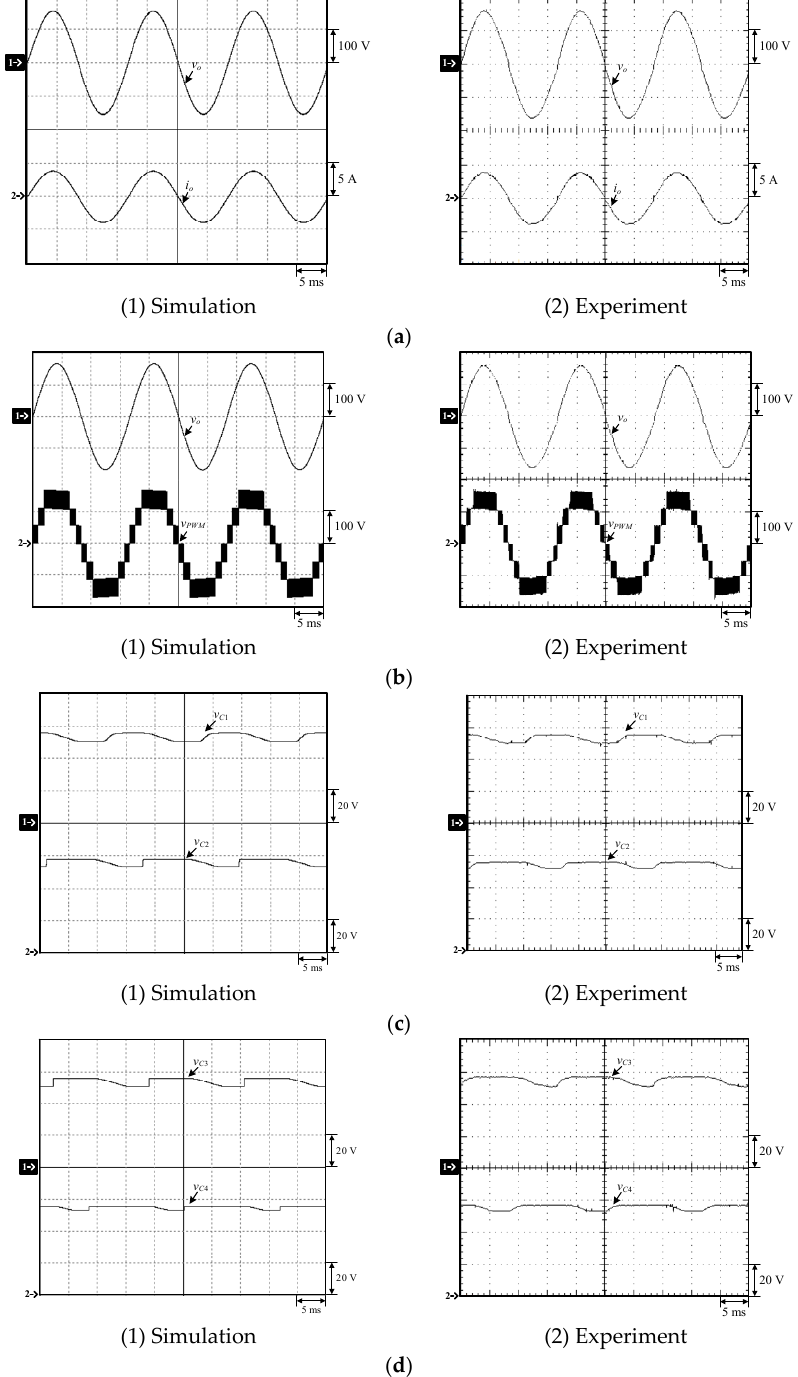
Figure 16. Simulated and experimental waveforms of the proposed DC-AC converter: ( a ) v o and i o ; ( b ) v o and v PWM ; ( c ) V C 1 and V C 2 ; ( d ) V C 3 and V C 4 .